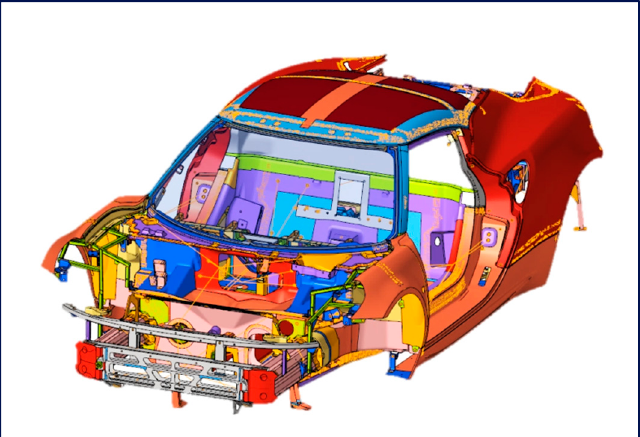
Figure 8. 4C car FE model. Table 1. Mesh details and mass of 4C car